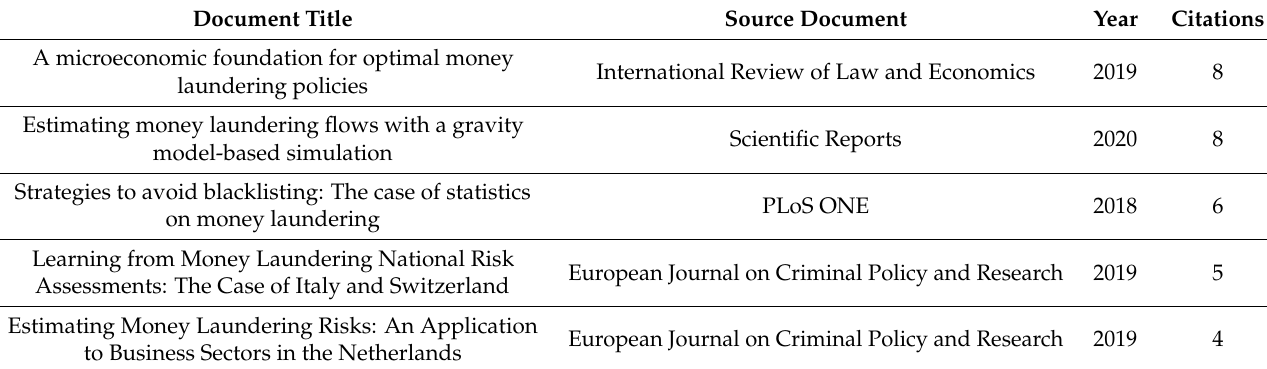
Table 9. Ferwerda’s journals and citations from 2017 to 2021.